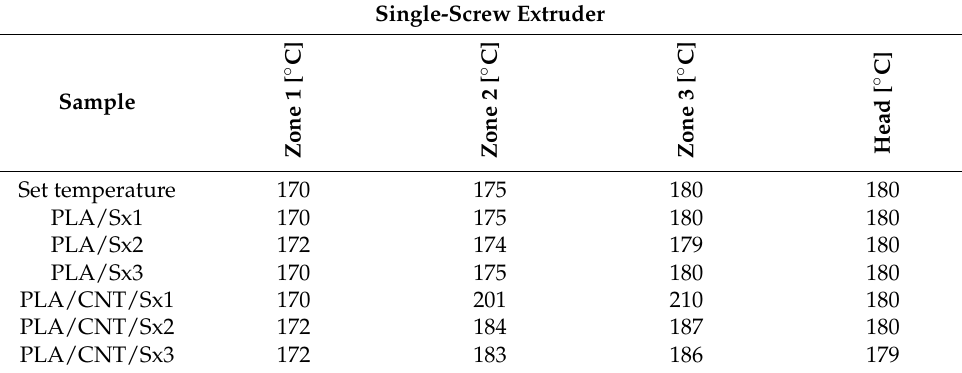
Table 4. Set and extrusion temperature—single-screw extruder.